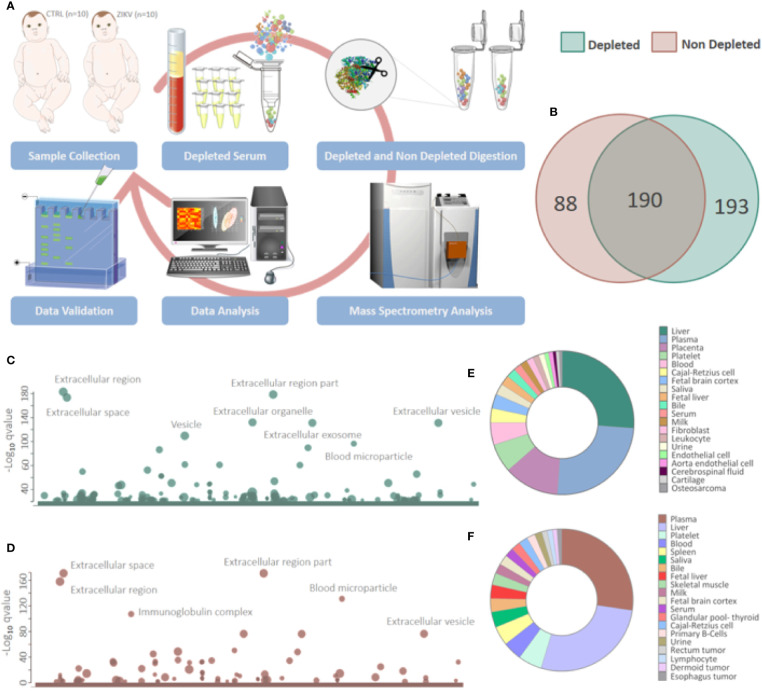
Proteins identified in depleted and non-depleted serum. (A) Workflow adopted for sample preparation and data analysis. (B) Venn diagram of proteins identified in the depleted and non-depleted serum. Only proteins identified by the Proteome Discoverer and PatternLab for Proteomics software were considered for posterior analysis. (C, D) Cellular components attributed to the total proteins identified in depleted and non-depleted treatment were determined using the tool g: Profiler. (q-value < 0.05). (E, F) Tissues that express identified proteins were evaluated by the Database for Annotation, Visualization and Integrated Discovery (DAVID) v6.8 platform. Only identifications with a p-value equal to or less than 0.05 and that present at least five proteins were considered.